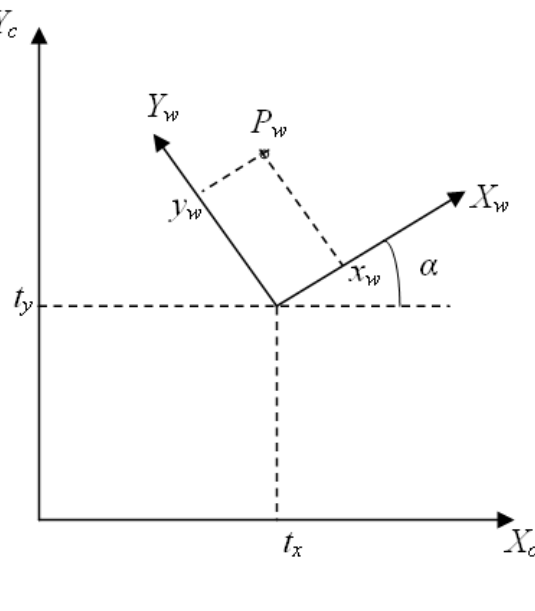
Figure 2. Relation between line-scan coordinate system and world coordinate